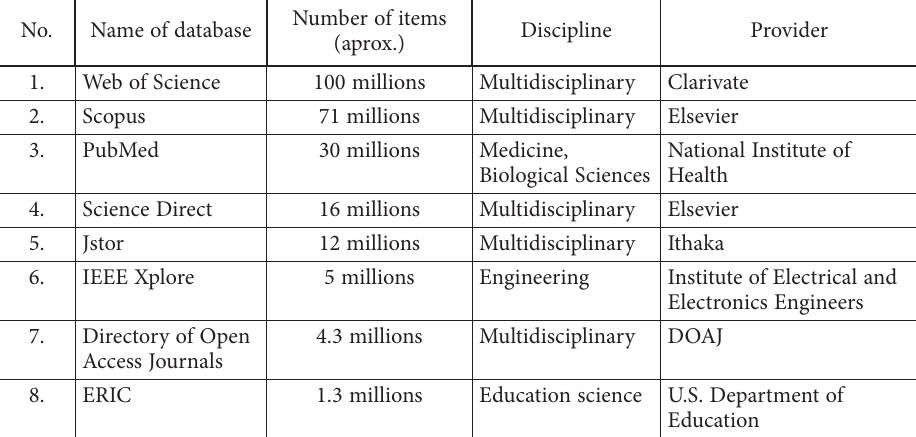
Table 1. Most important scientific databases (source: Paperpile, n.d.) Number of items No. Name of database